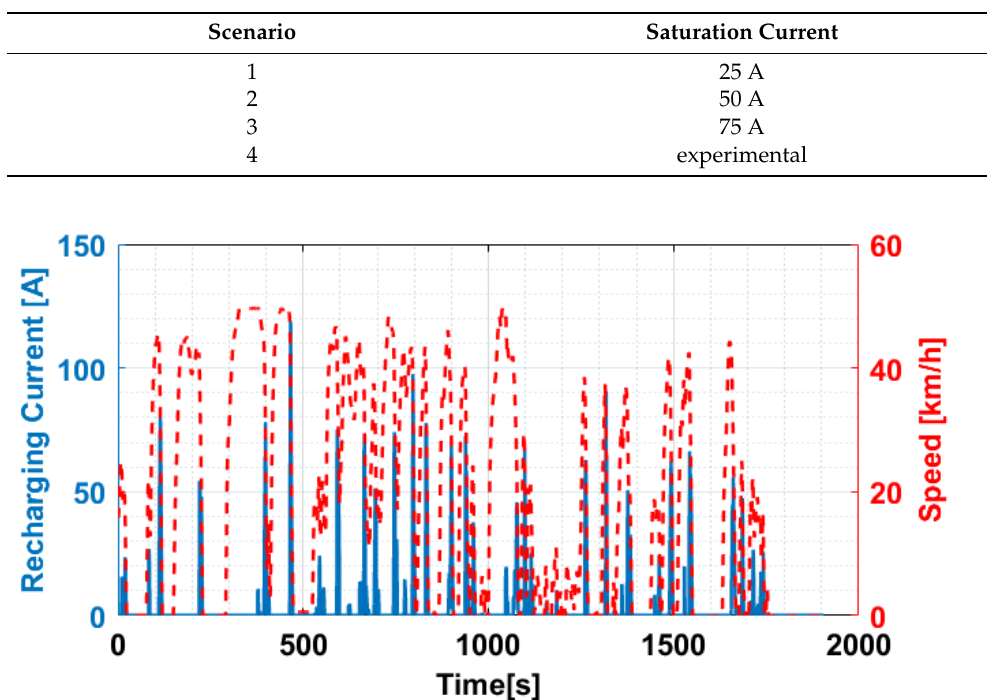
Figure 15. Recharging current during DM25.